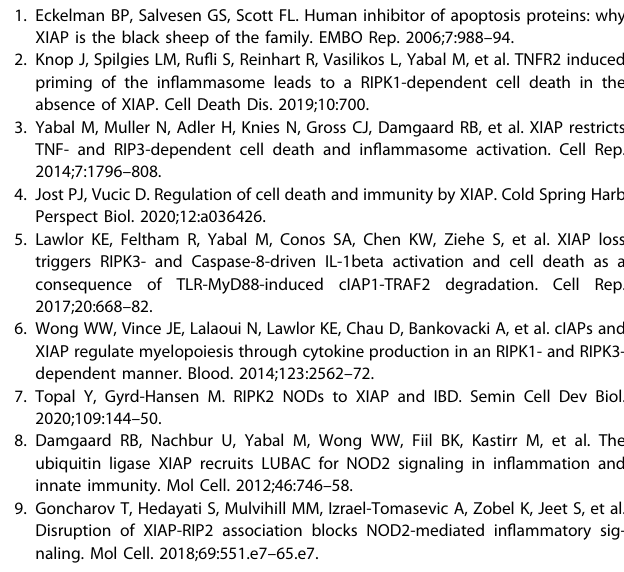
Fig. 4 XIAP de fi ciency promotes TNF stimulated and RIP1 dependent granulocyte depletion from spleen but does not affect TNF induced gene expression. WT and Xiap − / − mice were treated with vehicle or TNF (500 μ g/kg) for 3 h in the absence or presence of RIP1